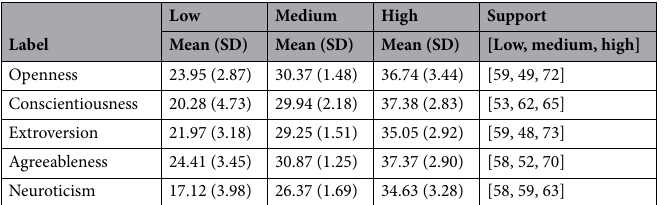
Table 3. Descriptive statistics for big five personality trait scores (out of 48) split by category.